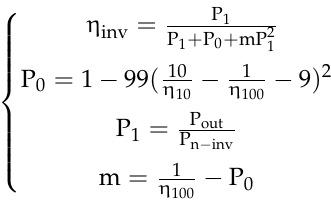
Figure 3. TST control.